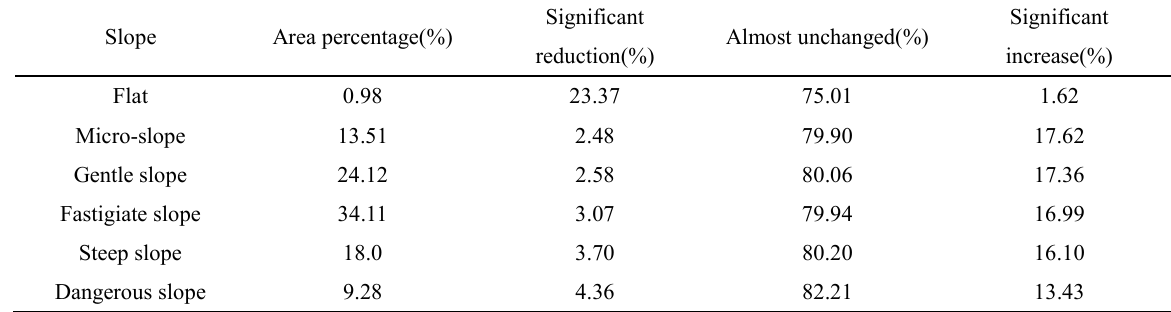
Table 3. Changes of FVC at different slope gradients in the source region of the Yellow